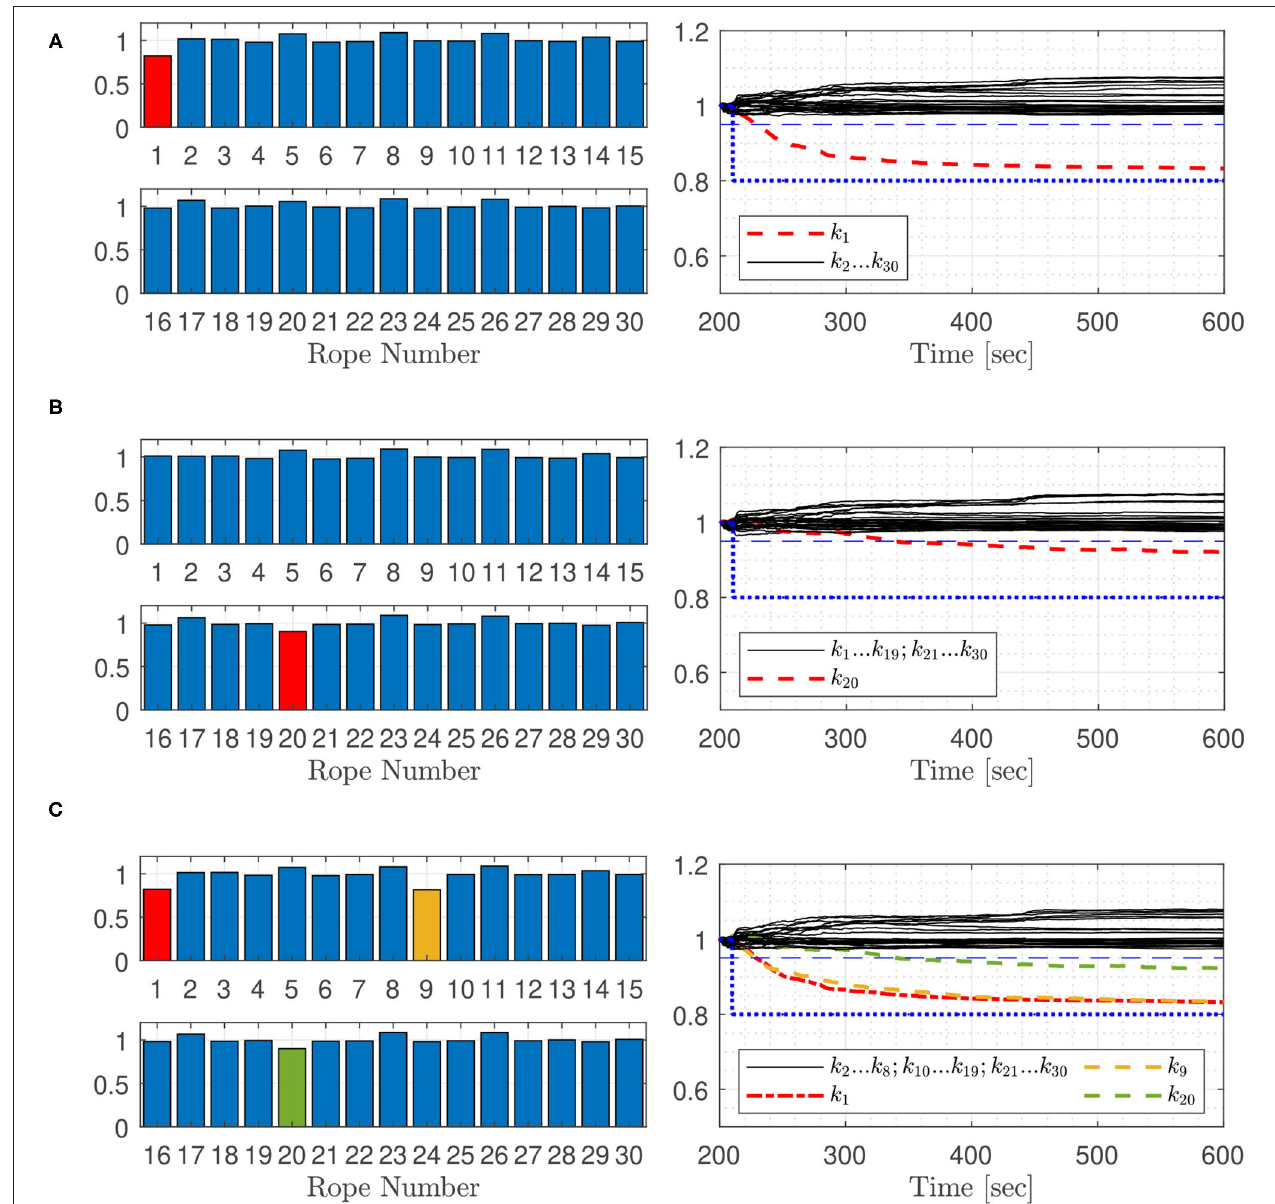
FIGURE 8 | Normalized estimated rope stiffness test cases 2A (A) , 2B (B) , and 2C (C) including uncertainties of model